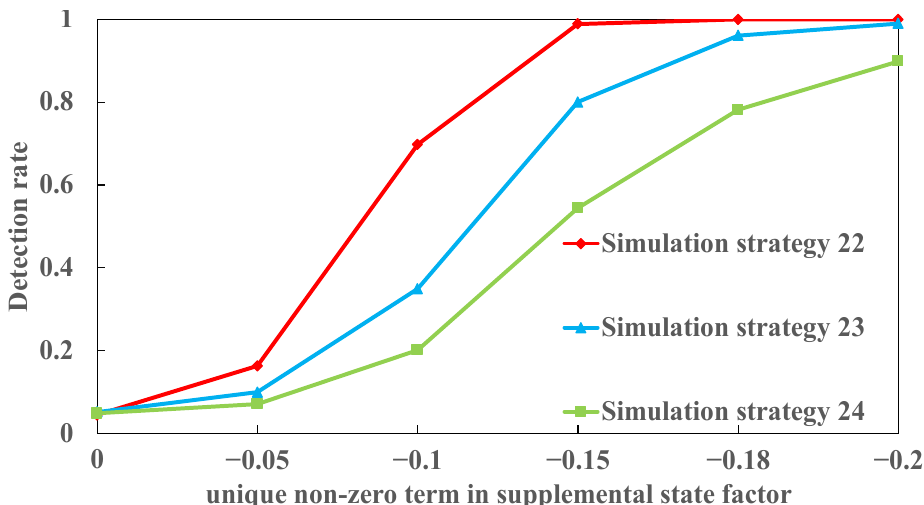
Figure 15. The detection rates in simulation strategies 22–24 when the value of the unique non-zero term in the supplemental state factor decreases from 0 to −